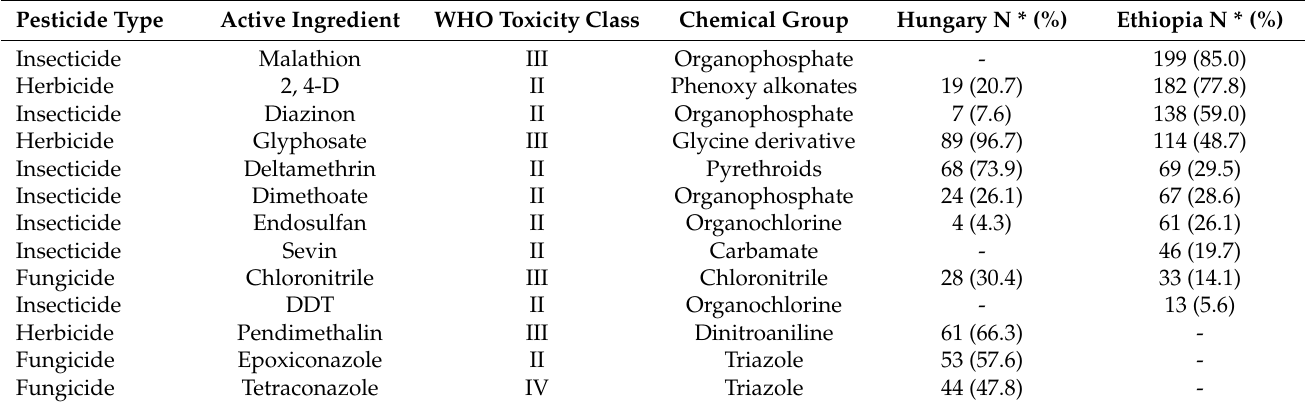
Table 3. Pesticides used as reported by officers in Hungary and Ethiopia.